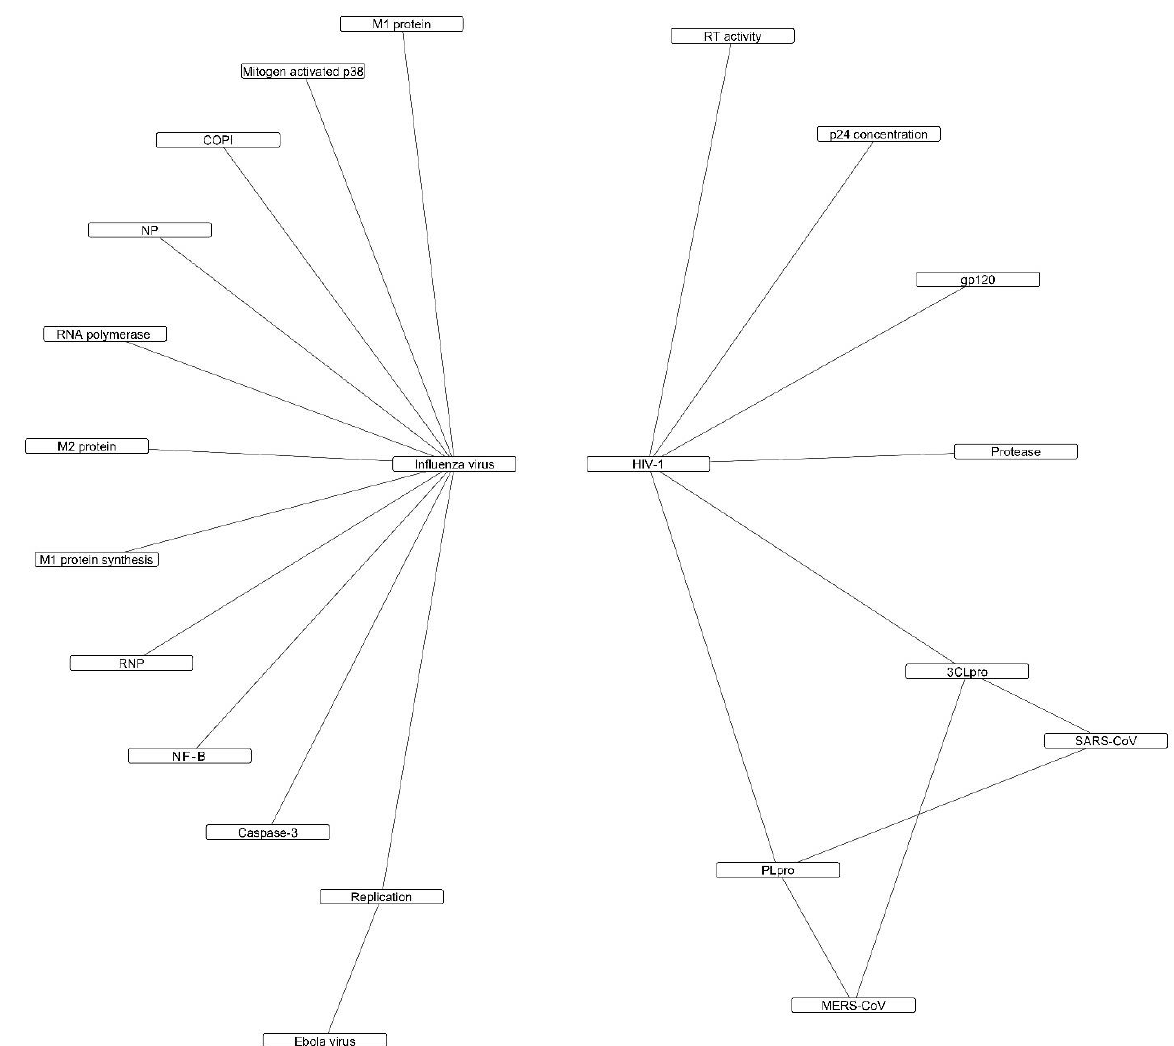
Figure 1. Direct antiviral mechanisms of flavonoids against viral infections with similar pathogenesis to SARS-CoV-2.